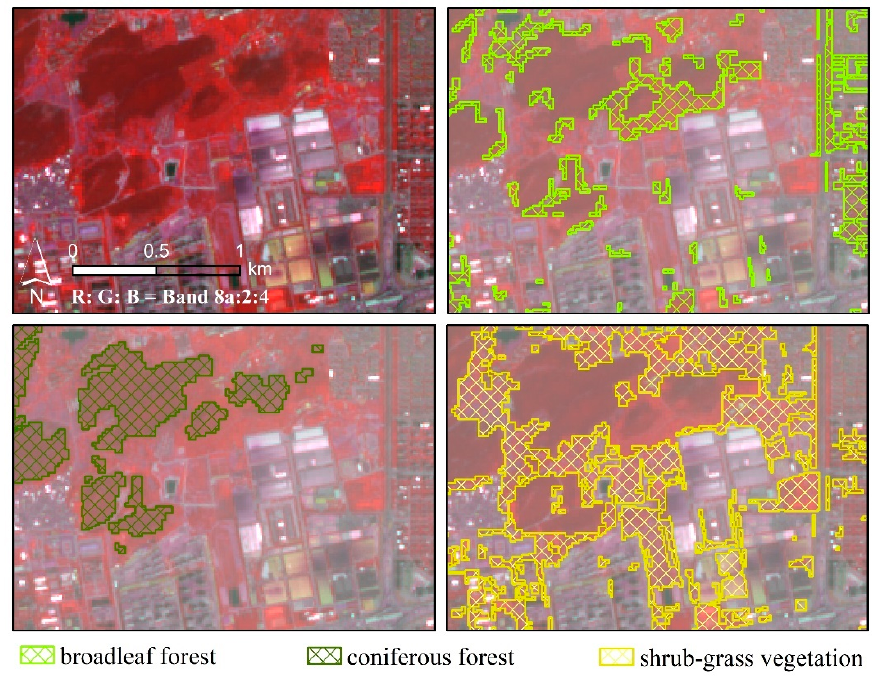
Figure 5. Comparison of UGS type identification results with ground-truth situation. Table 4. Areas for different types of UGS in the study area.